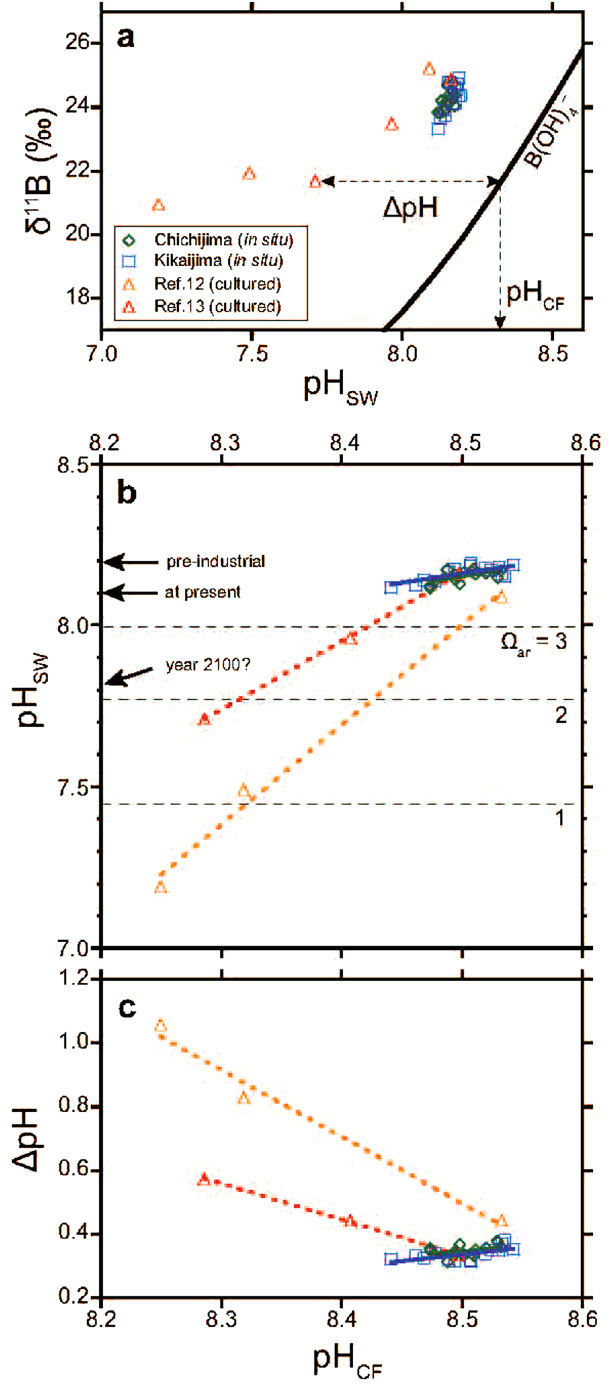
Figure 4. Relationships between pH SW and pH CF . ( a ) δ 11 B values for long-living and cultured corals (green diamonds, Chichijima Porites sp.; blue squares, Kikaijima Porites sp.; yellow triangles, cultured Porites sp., ref. 12; red triangles, cultured Porites cylindrica , ref. 13) with the theoretical curve for δ 11 B of the borate ion in seawater 25 . With the pH-upregulating mechanism, δ 11 B records not pH SW but pH CF , and Δ pH represents pH CF minus pH SW . ( b ) A cross-plot of pH CF versus pH SW . Regression lines are shown for each coral record. Dashed horizontal lines indicate pH values when Ω ar becomes 3, 2, and 1, which were calculated using present SST, SSS, and TA. ( c ) As in ( b ) but for pH CF versus Δ